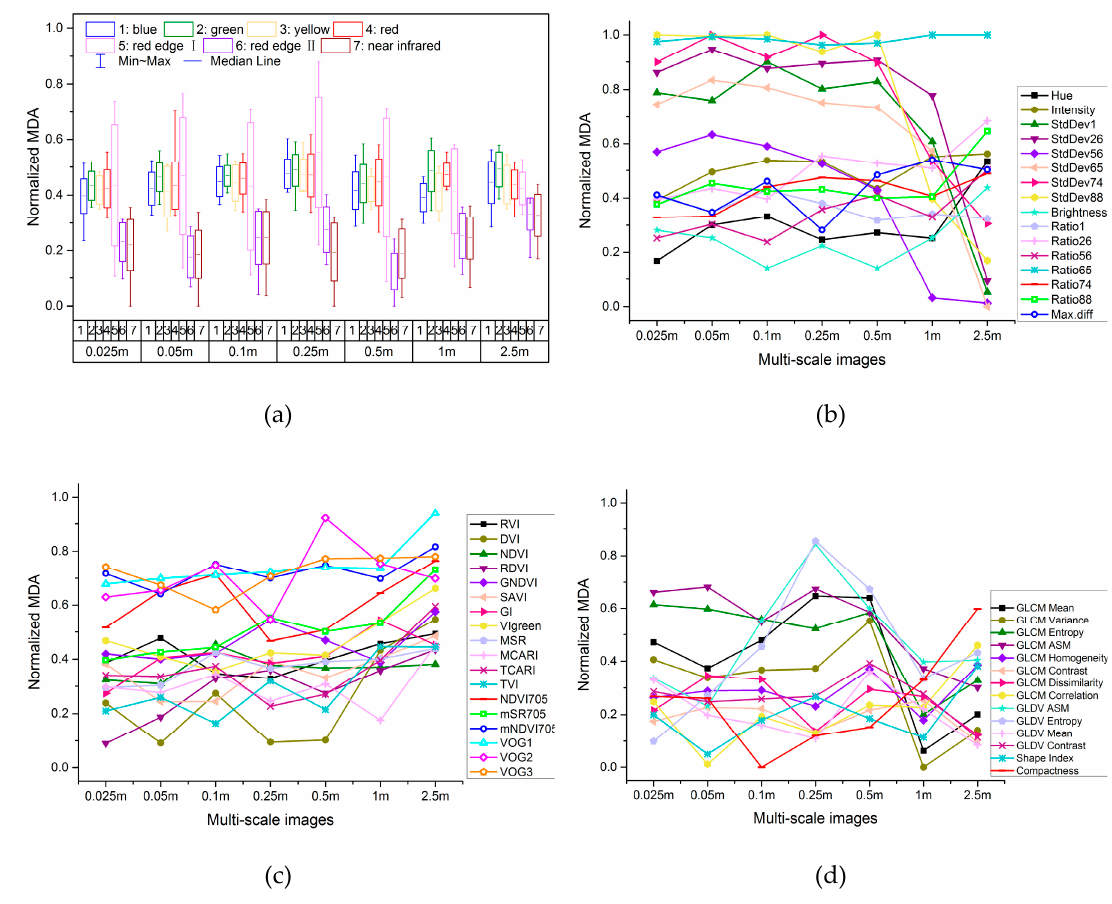
Figure 4. Importance measurement results of spectral, vegetation index, textural and shape features in multi-scale images. ( a ) Boxplot of the normalized mean decrease accuracy (MDA) for 101 reflectance features; ( b ) normalized MDA for other spectral features; ( c ) normalized MDA for vegetation index features; ( d ) normalized MDA for textural and shape features.